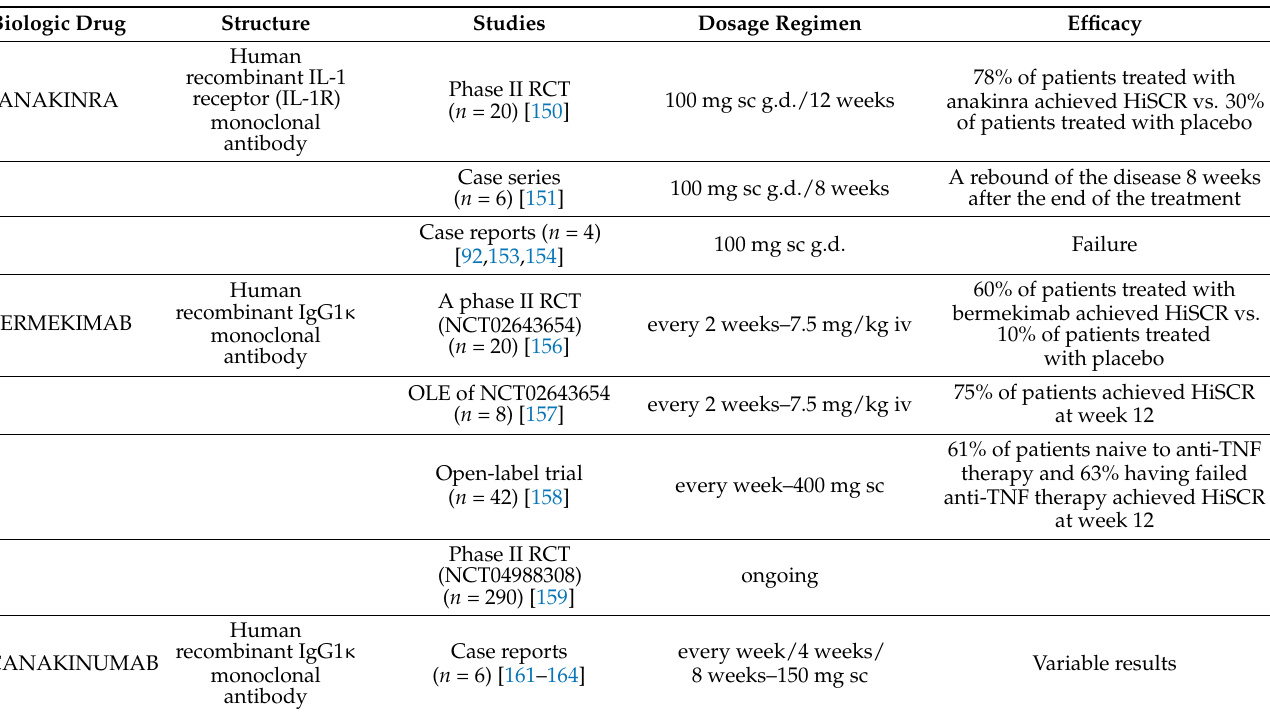
Table 7. Anti-IL-1 agents for HS